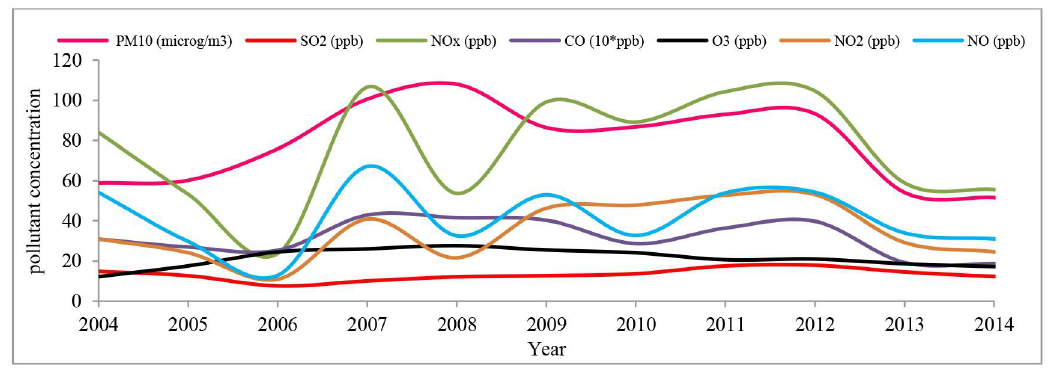
Fig 3. Dynamic trends in the annual mean concentration of air pollutants in Tabriz (2004–2104)—(Data source: [80]).